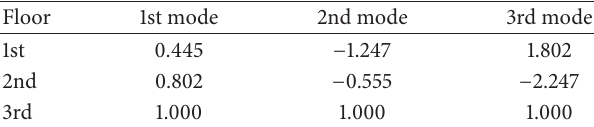
Table 1: Mode shapes of example structure.